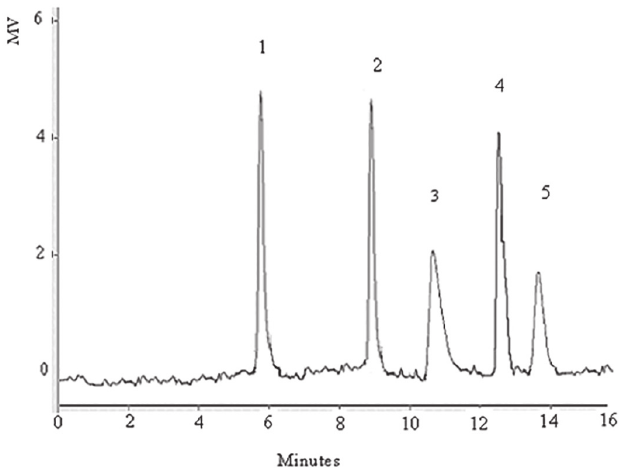
FIGURE 4 - Chromatogram in plasma